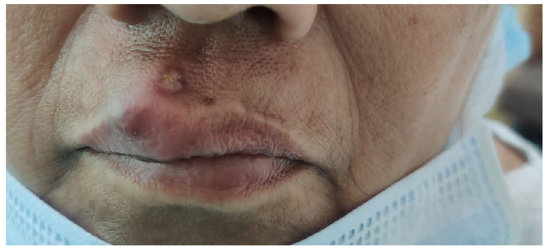
Fig. 1 Preoperative photo showing the swelling over the upper lip (extra-oral)